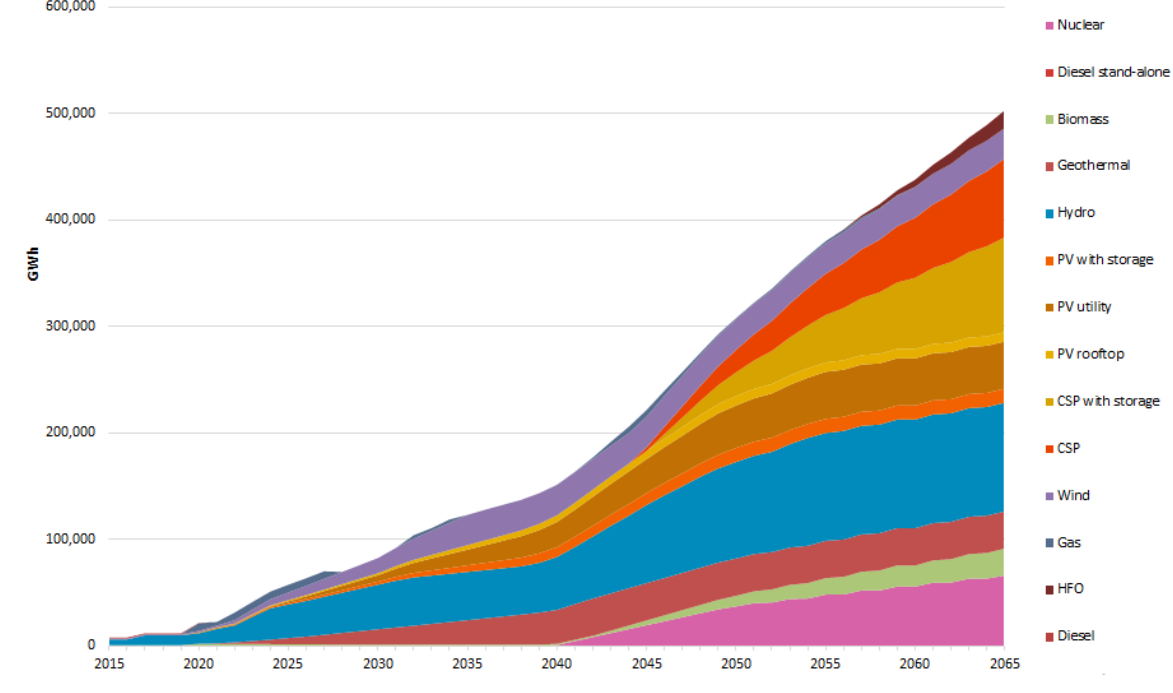
Figure 3. Electricity supply mix of grid-connected technologies in the Drought scenario. Table 3. Comparison of Electricity supply of Drought and New Policy Scenario .